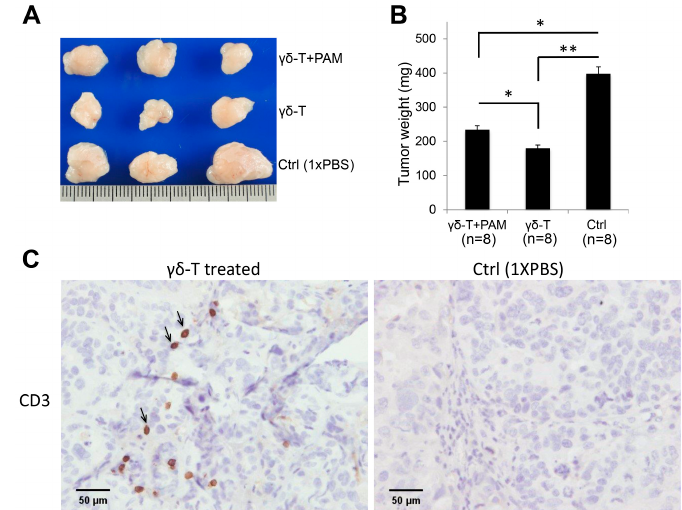
Figure 6. Repeated systemic administration of expanded γδ -T-cell infusions showed significantly enhanced antitumor efficacy of γδ -T-cell therapy in vivo. The endpoint dissection of schedule 2 treated-mice. ( A ) Tumor masses from different mice groups. ( B ) The mean tumor weight (mg) from each treated mouse group ( n = 8 per group; * p < 0.05, ** p < 0.01). ( C ) γδ -T-cells confirmed by CD3-IHC staining in tumor sections from different mice groups. CD3 positivity (black arrow) indicated γδ -T-cell infiltration ( C , left).